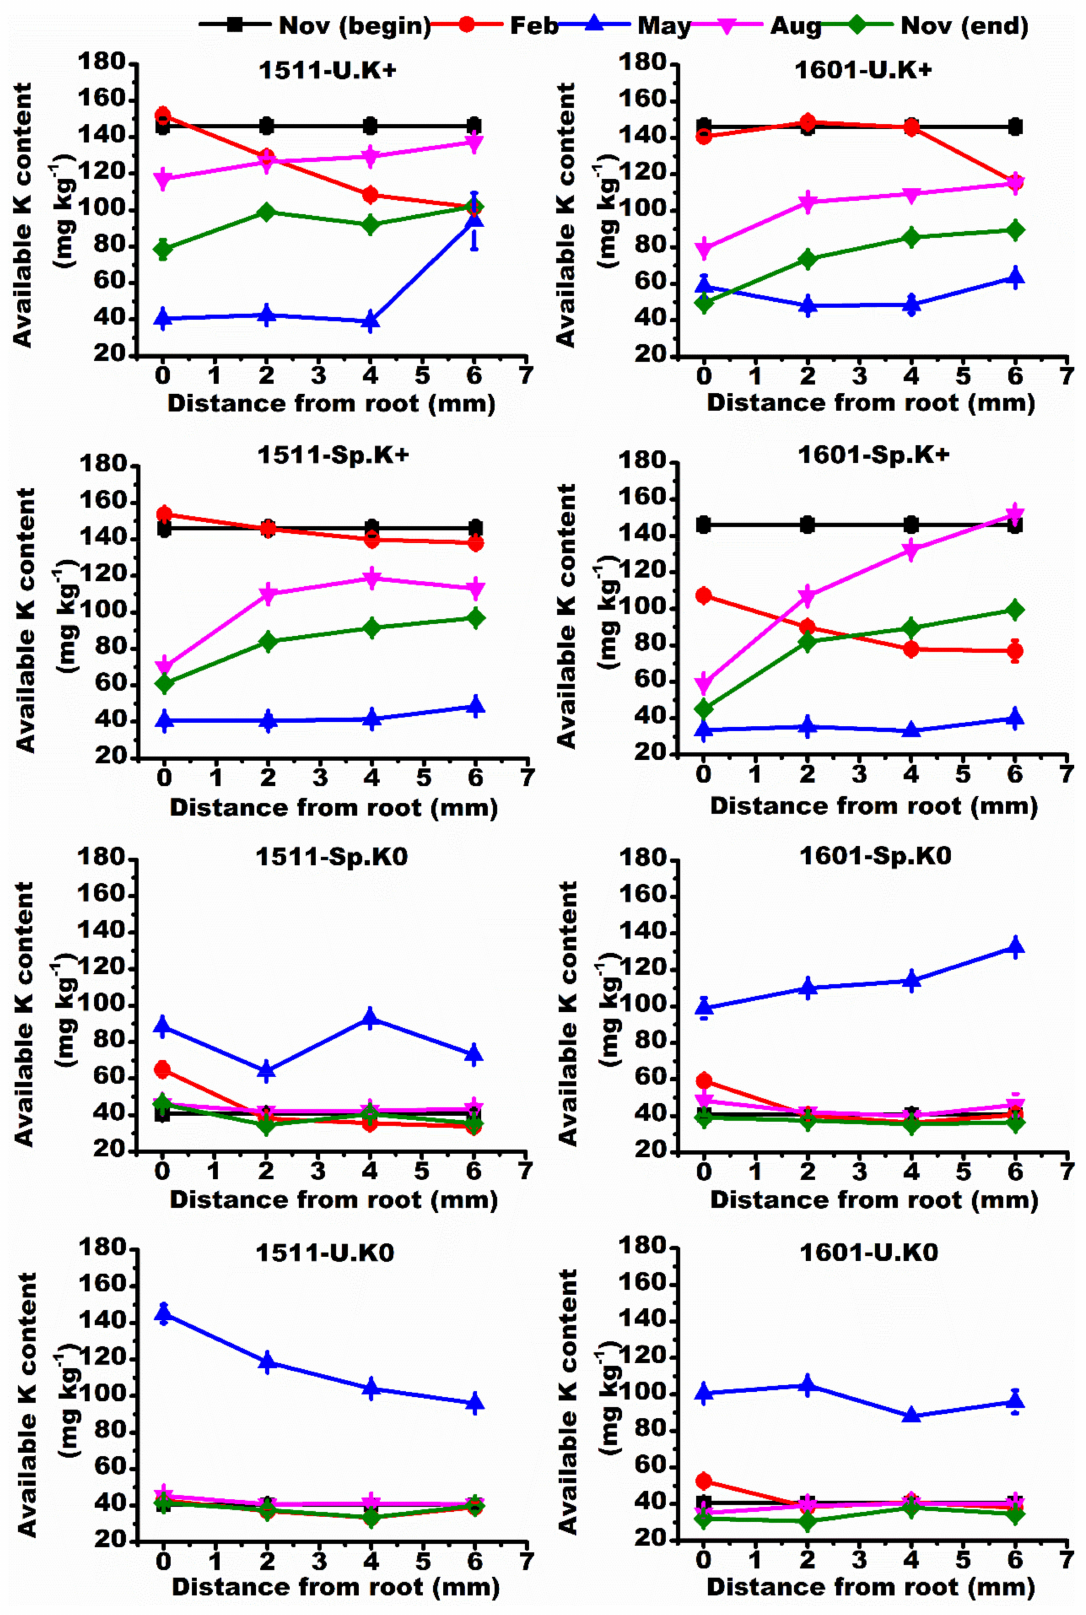
Figure 4. Spatiotemporal variations of available K contents in soils. Different colored lines represent the spatial distribution of soil slowly available K in different months. Data are means ± SE ( n =